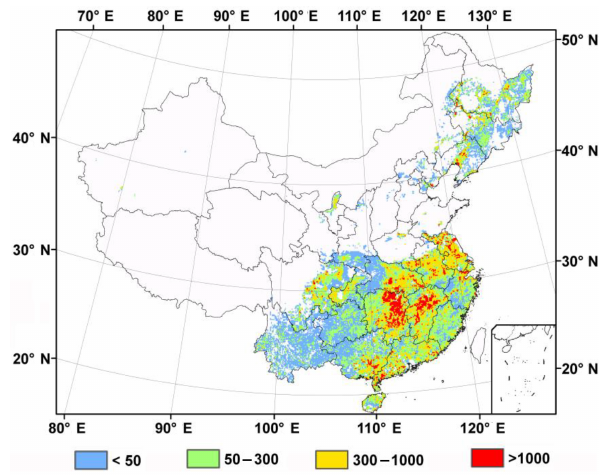
Figure 7. Spatial distributions of rice paddy methane emissions ( × 10 6 gCH 4 per 10km × 10km grid).